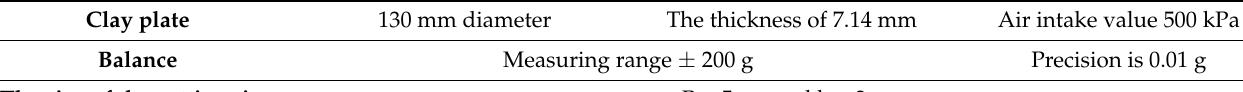
Table 1. Main technical parameters.